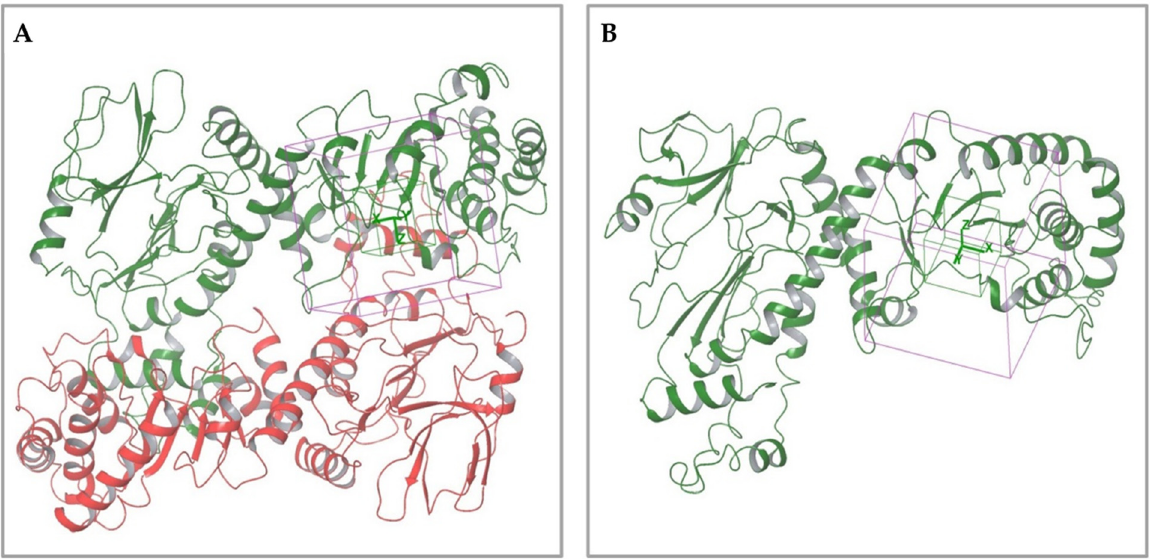
Figure 3. Representation of the NAPRT active site grids employed in docking-based virtual screenings. ( A ) Docking grid of the functional dimeric model of human NAPRT. ( B ) Docking grid of the human NAPRT monomer.